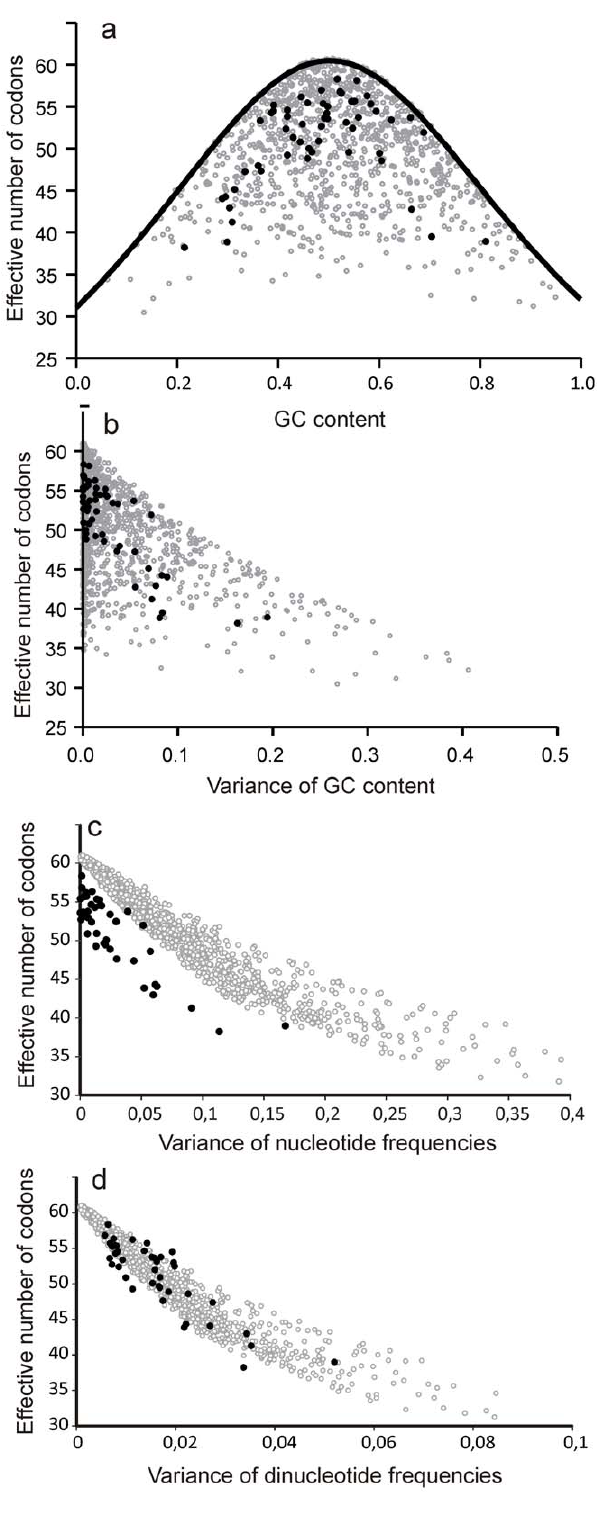
Figure 3. Plots of ENC vs. sequence content in 29 RNA viruses indicated in Table 1 (black dots) and in 1000 simulated sequences with random third-position nucleotide content (gray circles). Plot of ENC against GC content (A), variance of third- position GC content (B), variance of third-position nucleotide frequen- cies (D) and variance of dinucleotide frequencies at codon position 2-3 (D). Solid line in panel (a) indicates theoretical prediction of ENC as a function of GC content bias [31].